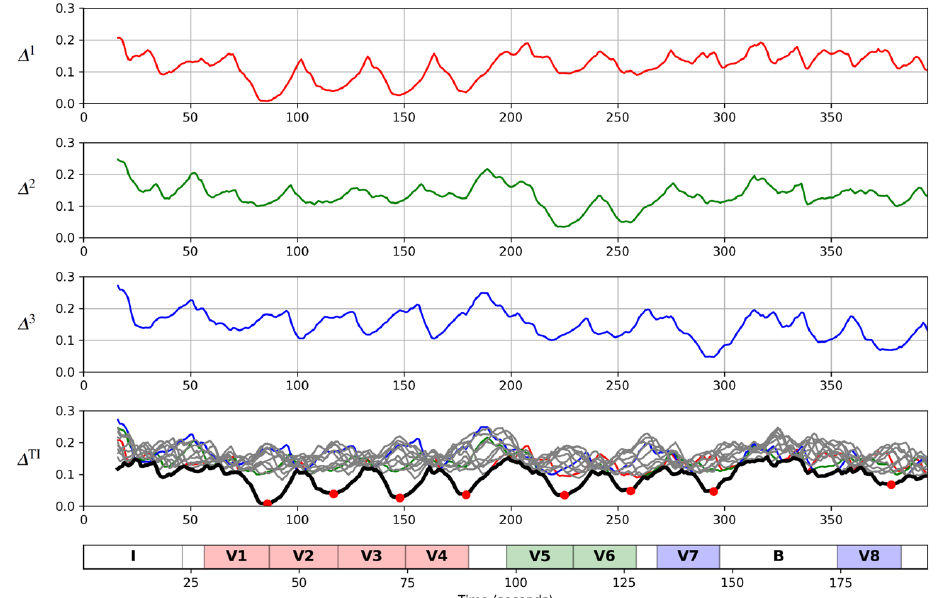
Figure 19. Transposition-invariant matching function illustrated by Zager and Evans’ song “In the Year 2525.” The song has the musical structure IV 1 V 2 V 3 V 4 V 5 V 6 V 7 BV 8 O , with some verses being transposed. Using a chroma-based representation of V 1 and cyclically shifted versions as queries leads to several matching functions ( ∆ 0 , ∆ 1 , ∆ 2 , . . .), which are combined to form a transposition-invariant matching function ∆ TI (thick black